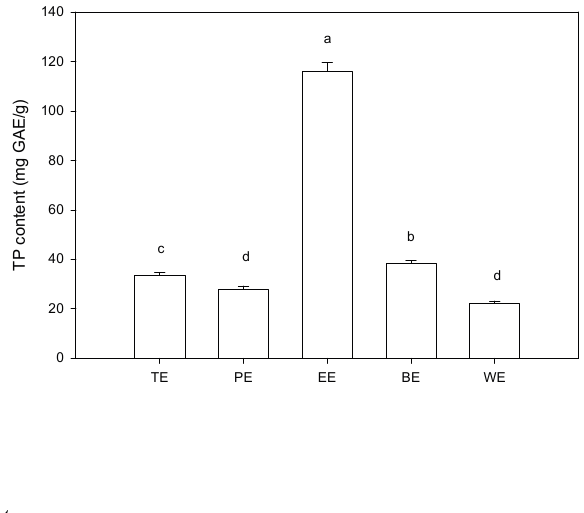
Figure 2. Total phenolic content in different extracts of sugarcane tops. TE, PE, EE, BE and WE were the abbreviations of total extract, petroleum ether extract, EtOAc extract, n -BuOH extract, and water extract, respectively. Different letters horizontally (a–d) indicated signi fi cant differences ( p < 0.05) of total phenolic content among different extracts according to Duncan’s multiple range